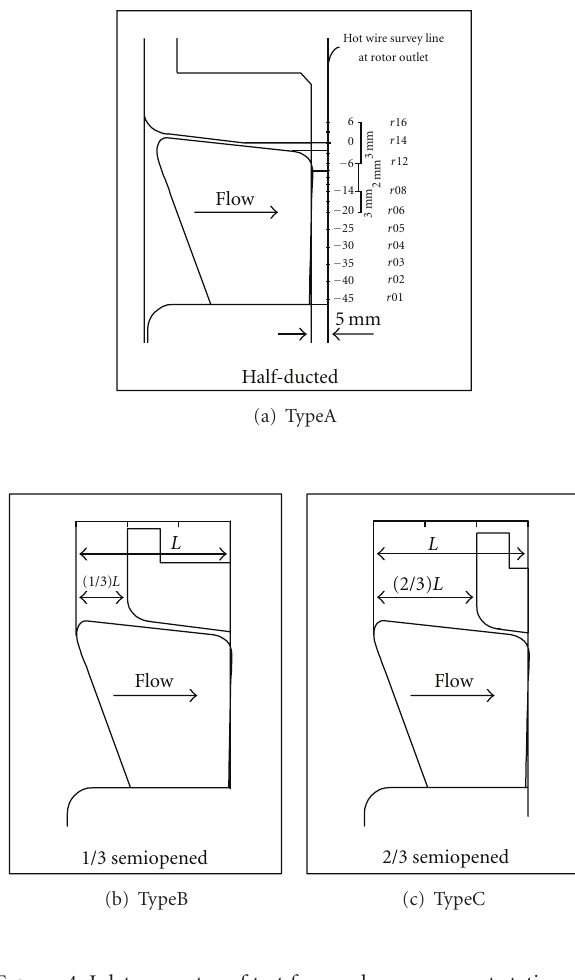
Figure 4: Inlet geometry of test fans and measurement stations of hotwire survey at rotor outlet.